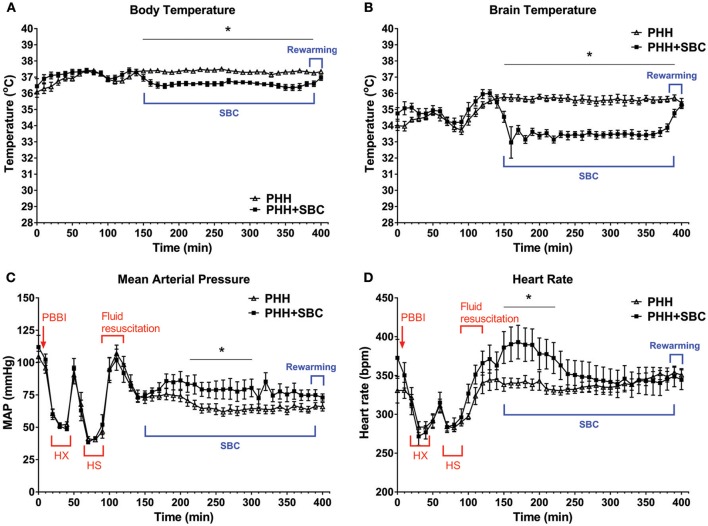
Acute physiological parameters. Body temperature (A), brain temperature (B), mean arterial pressure (C), and heart rate (D) were monitored continuously from pre-injury baseline to the end of rewarming. Data was analyzed as 2-min averages taken at 5-min intervals across the 400-min recording period. For better visualization, data was plotted every 10 min on these graphs. PHH group n = 13; PHH+SBC group n = 12. *p < 0.05 (two-way repeated ANOVA with S-N-K post-hoc test).